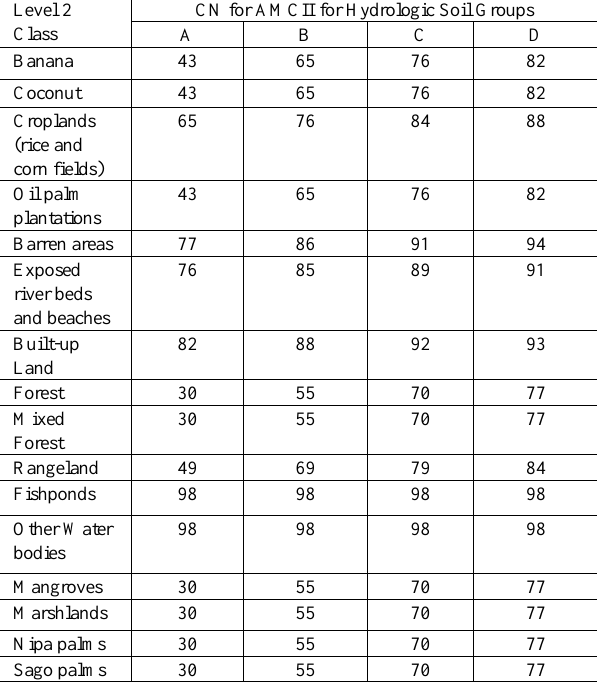
Table 2. CN values for Level 2 land cover types and hydrologic